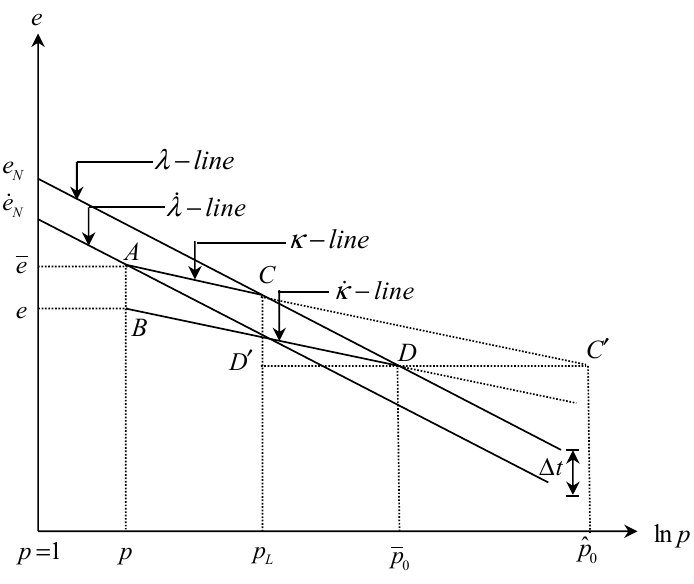
Figure 3. Relative locations of p cl , p cr and p cp